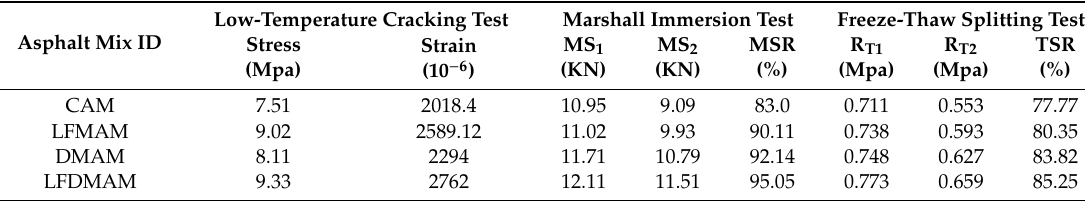
Table 7. Experimental results of di ff erent asphalt